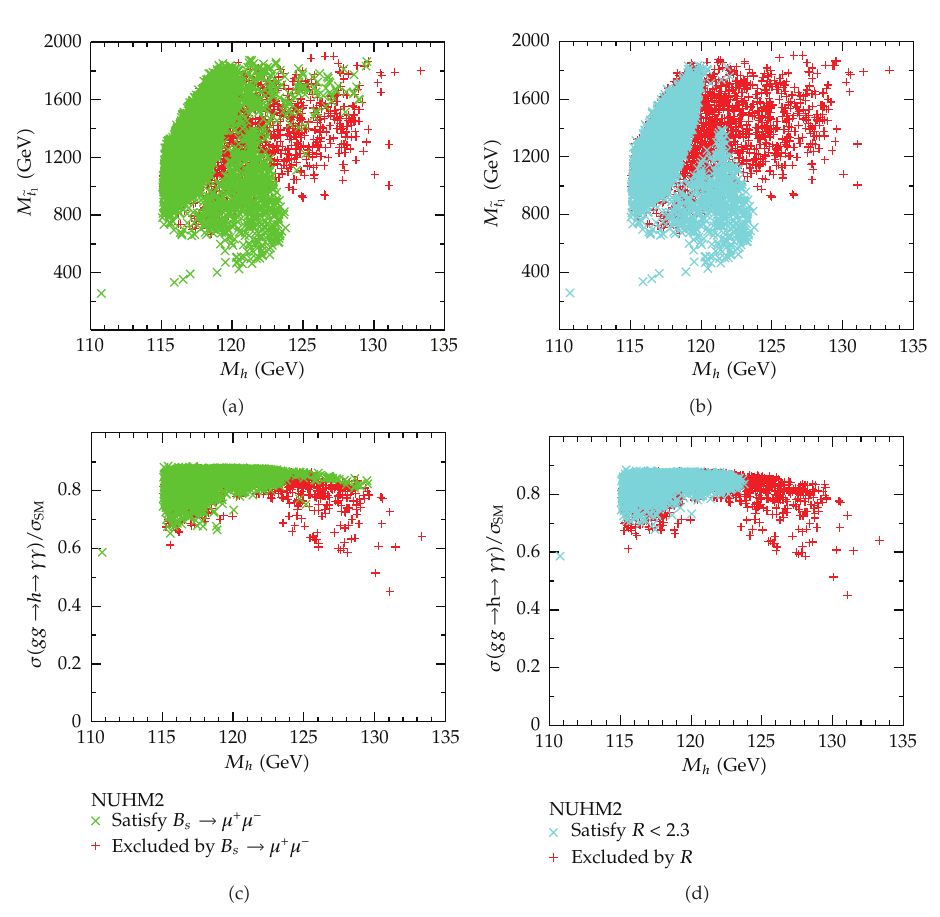
Figure 8: Same as Figure 7, but for the NUHM2 (cid:3) taken for (cid:5) 43 (cid:6)(cid:4)